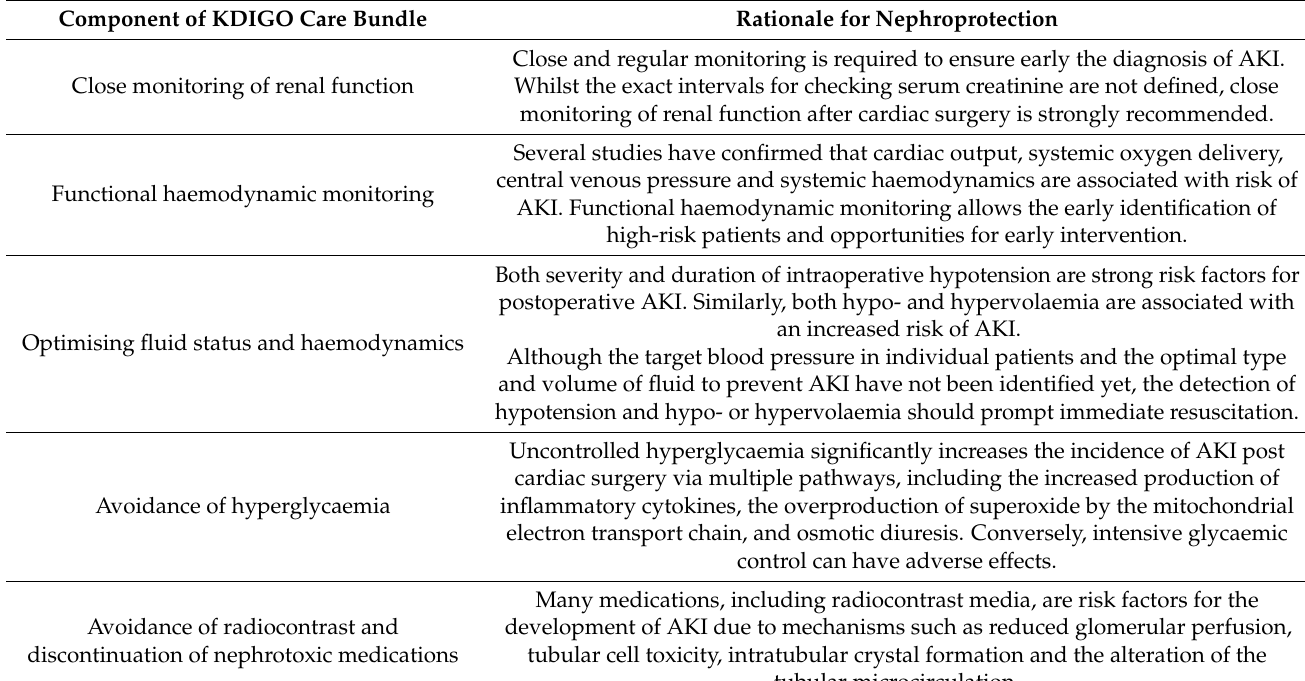
Table 1. KDIGO bundle recommendation and their